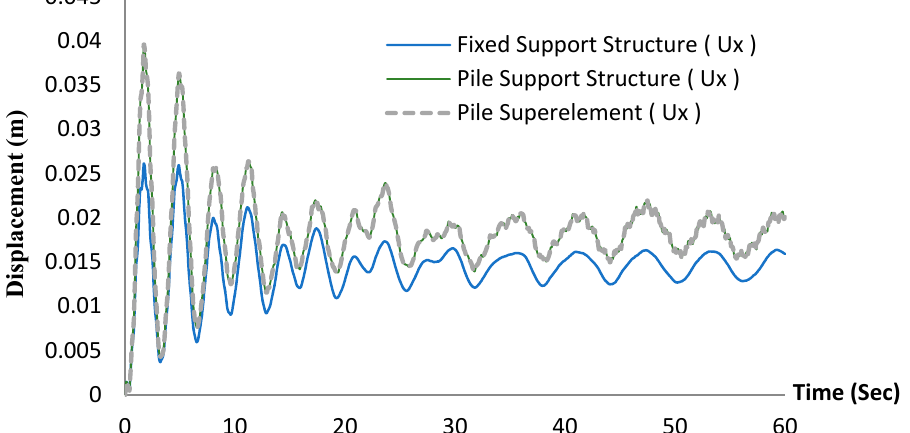
Figure 19. A comparison of the displacements in x-direction of the fixed support structure model, piled support structure model and piled superelement model.